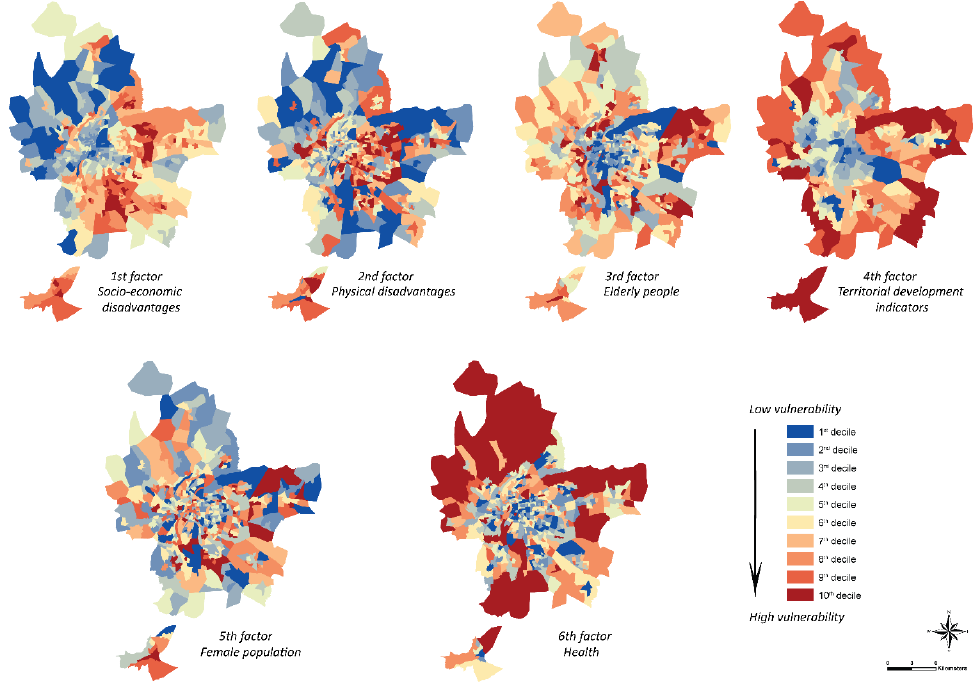
Figure 7. Spatial representation of socio-economic vulnerability in the Metropolis of Lyon to heat waves by factors — discretization by equal intervals.